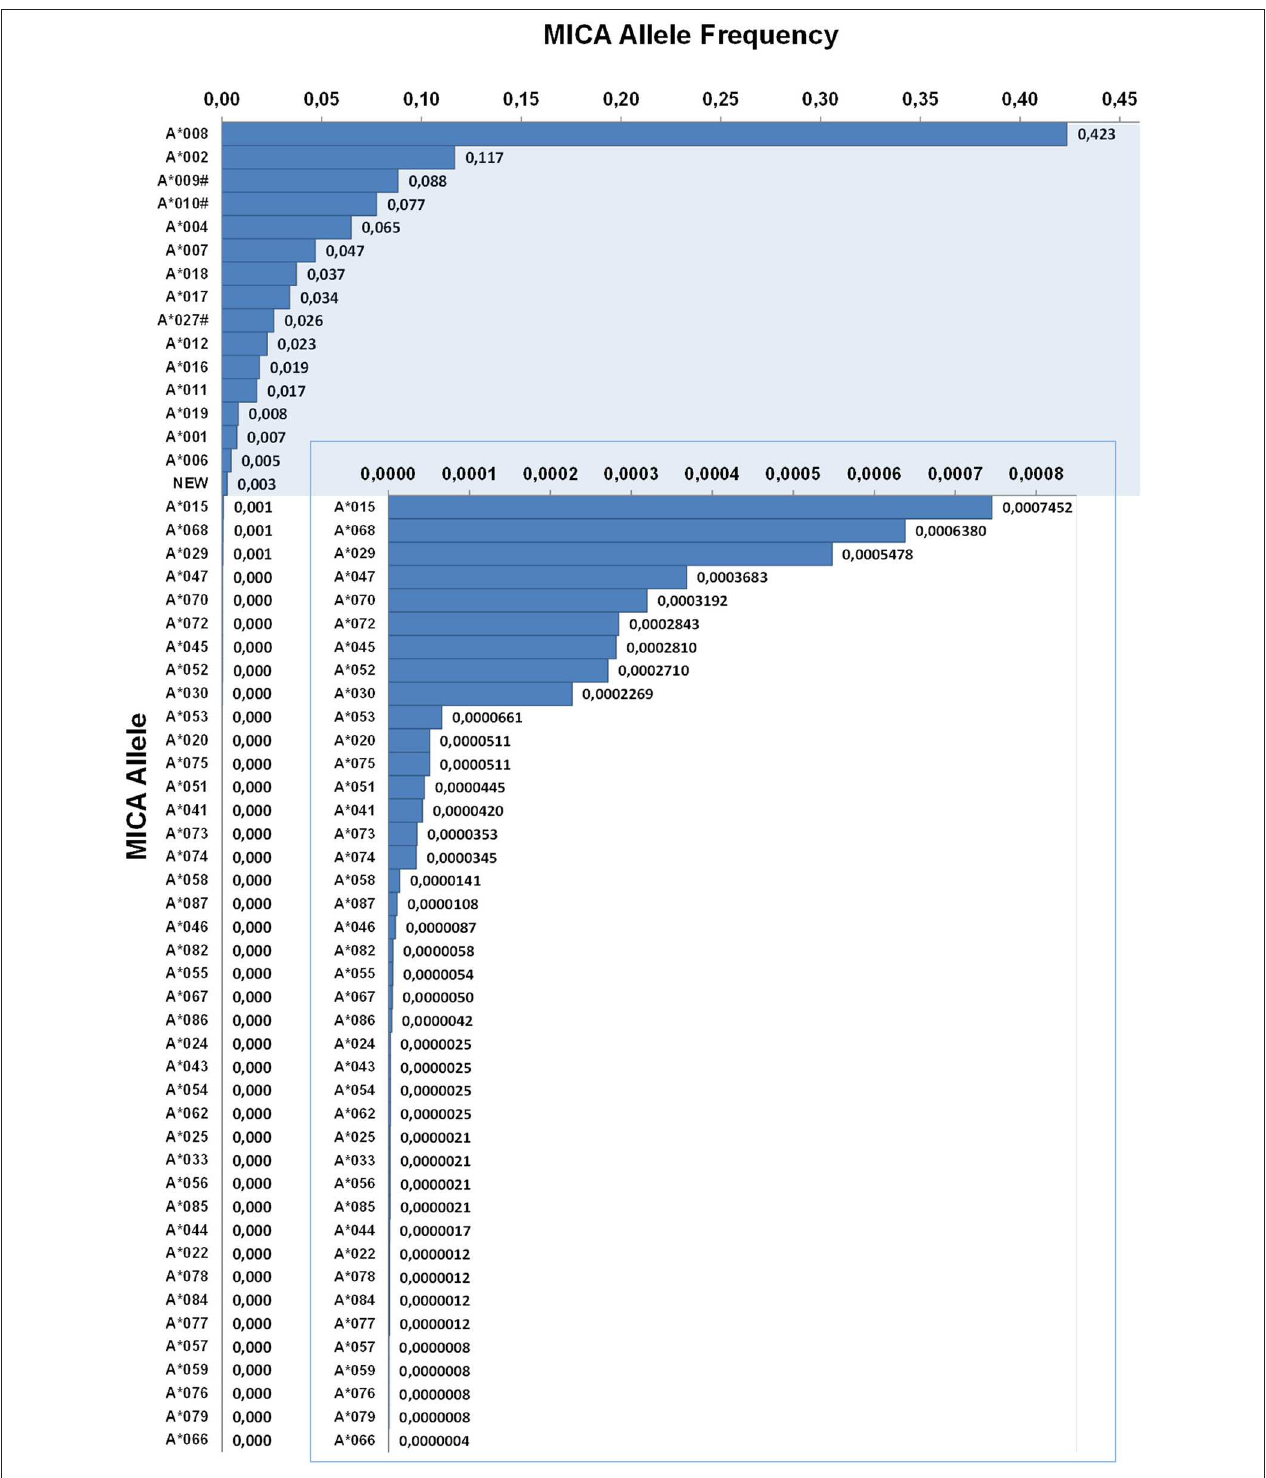
FIGURE 2 | Allele frequencies of MICA . First-field-resolution allele frequencies are based on 1,201,896 samples from donors of German descent. Alleles contributing to a cumulative allele frequency of 99.5% are shown against a colored background and allele frequencies below 0.003 are additionally plotted in an inlay. If ambiguities exist, allele groups are used (#) and the ambiguity is described in Table 1